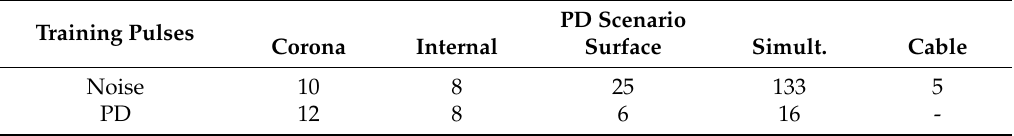
Table 6. Size of the OCSVM detectors in terms of the number of training instances that define f ( x ). The top row shows the size of the models trained with background noise signals. The bottom row shows the size of the models trained with PD